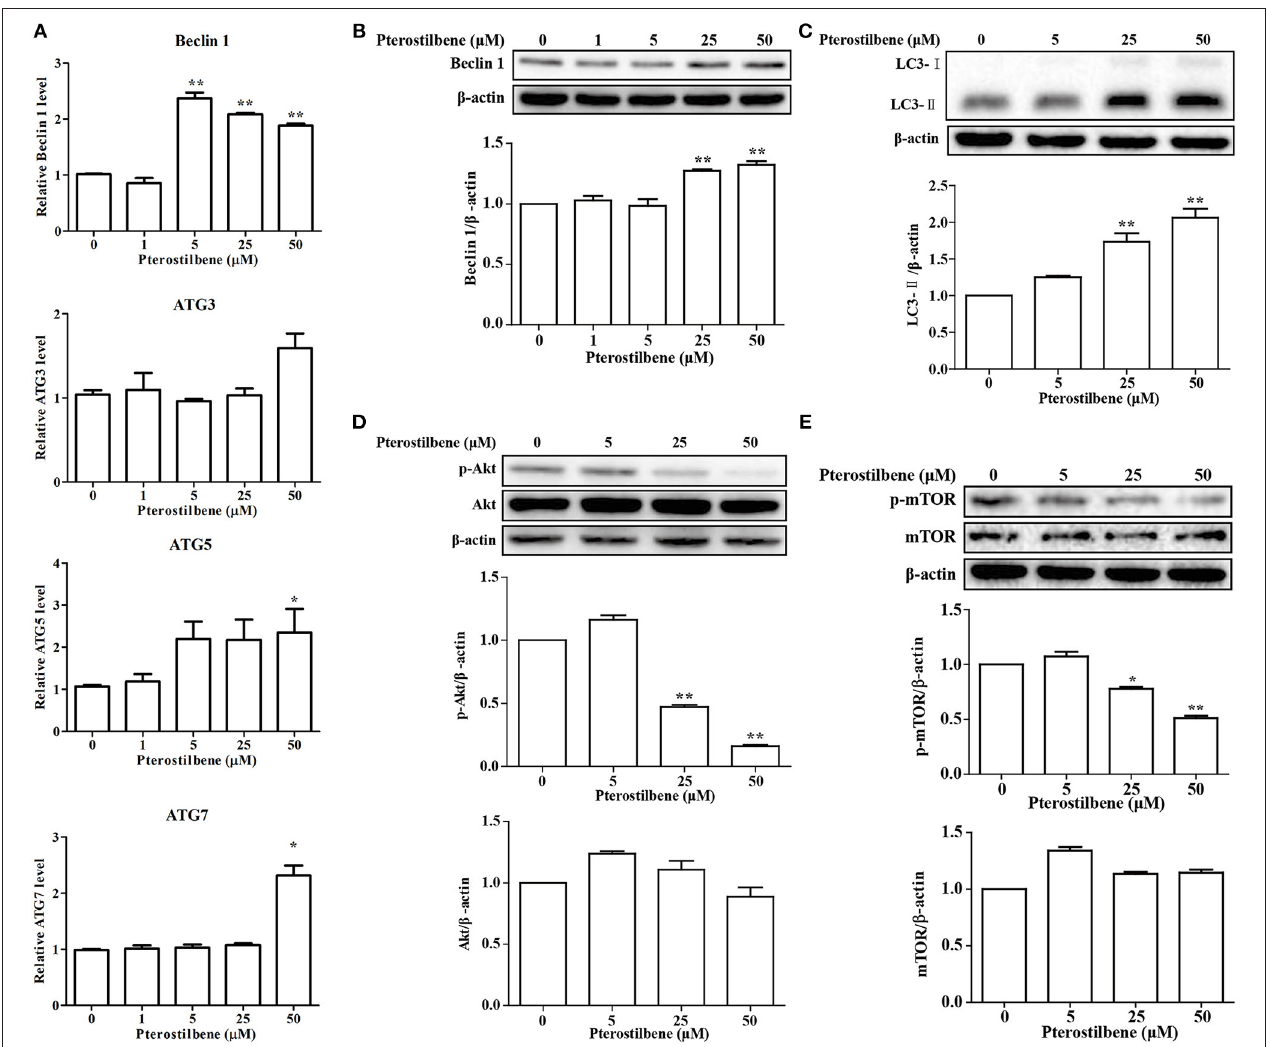
FIGURE 3 | Pterostilbene triggered autophagy in cancer cells: (A) Expression of autophagy-related genes determined by qRT-PCR; (B–E) Expression of autophagy-related genes by Western blot analysis. Reported values are mean ± SEM. * p < 0.05 and ** p < 0.01, indicate significant differences compared with the control